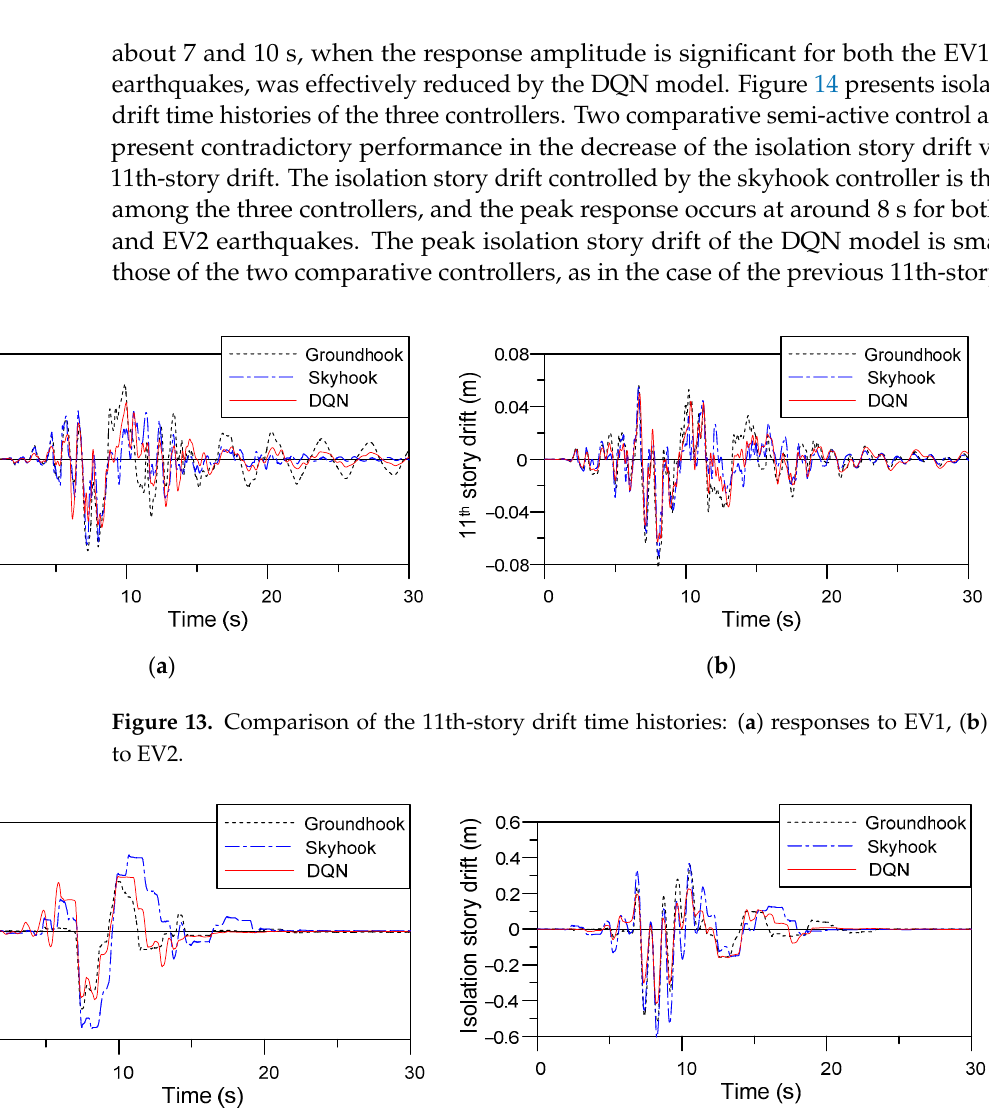
( b ) Figure 12. Idealized semi-active control configurations: ( a ) skyhook, ( b ) groundhook. After 10,000 episodes of reinforcement learning training, the DQN model was ob- tained to control the SMIS. Python 3.5.0 was employed to program the DQN model and environment generation codes, with Tensorflow 1.6.0 as a machine learning library. Time history analyses of the sample building structure with the SMIS were performed to inves- tigate the seismic response control performance of the DQN model. An artificial ground acceleration not used for training was used for dynamic time history analysis.